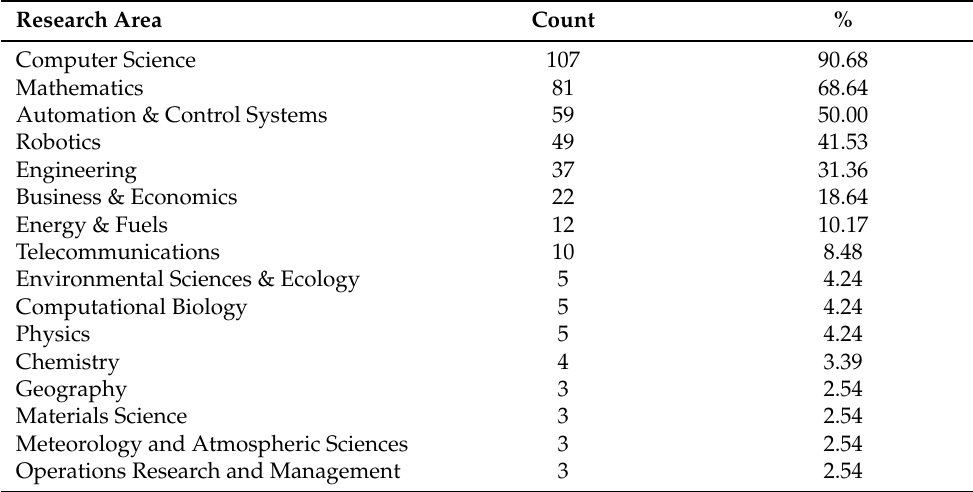
Table 4. Summary of the main research areas.